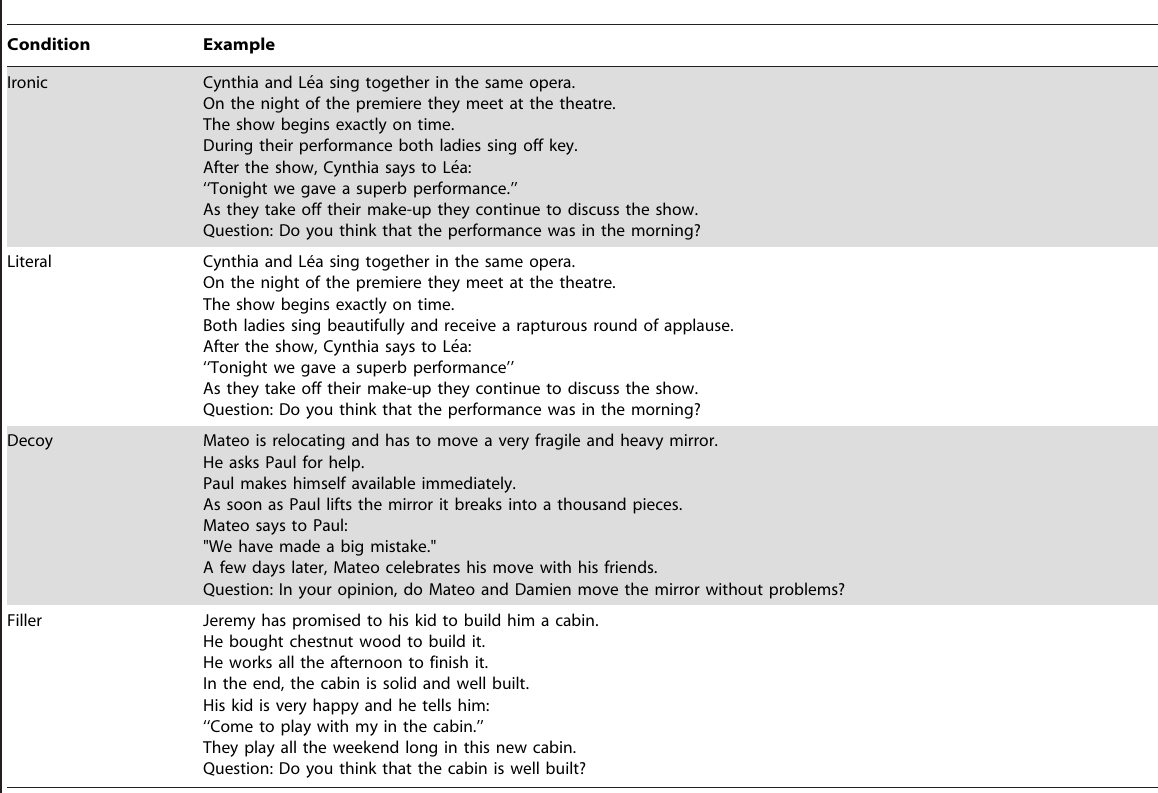
Table 1. Examples of the four kinds of stimuli (translated from French).